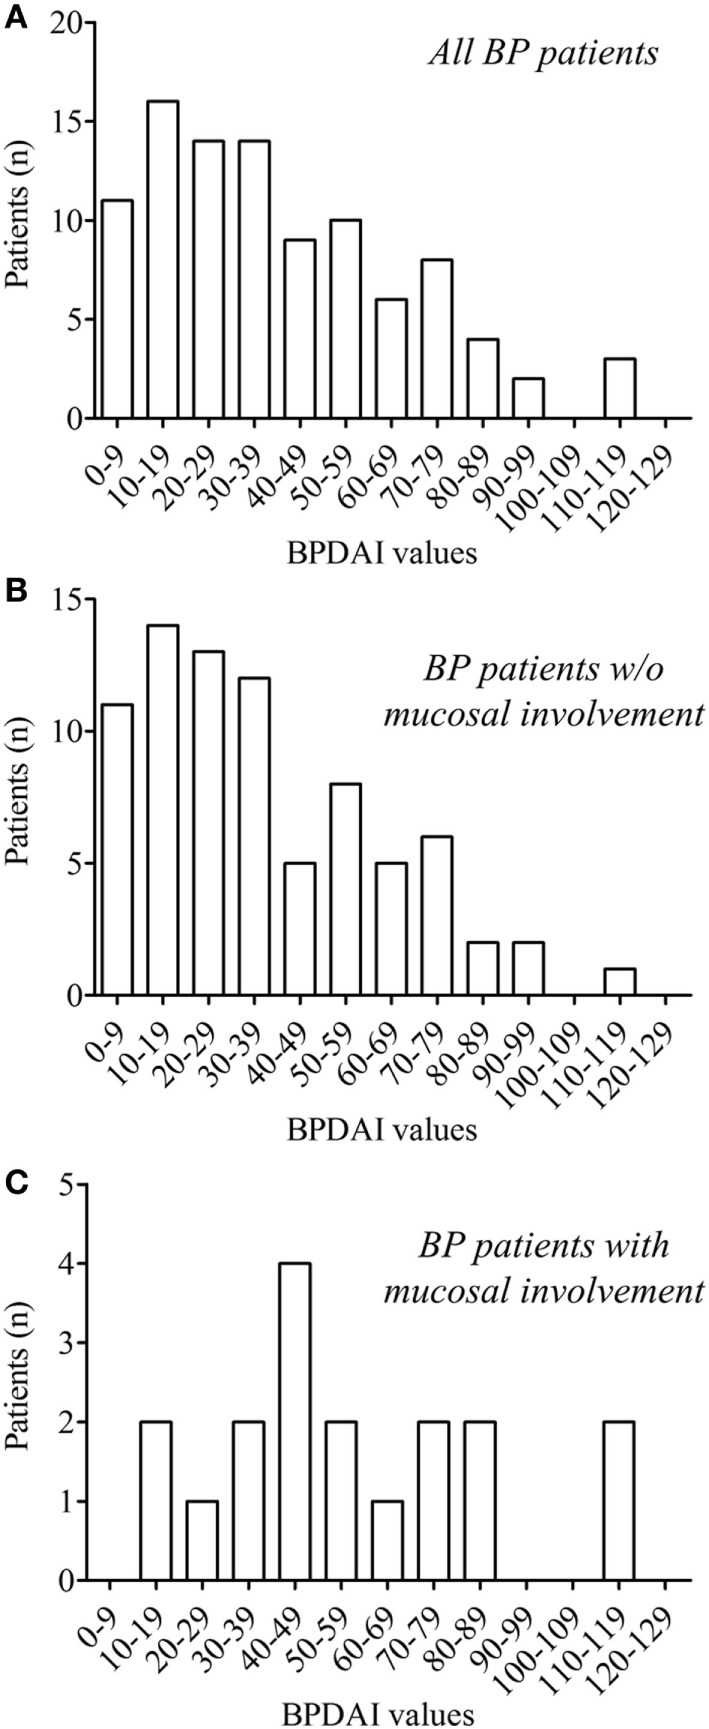
Distribution of the whole bullous pemphigoid (BP) patients (n = 95) (A) and of BP patients without (n = 77) (B) and with (n = 18) (C) mucosal involvement according to total BP Disease Area Index (BPDAI) values at the time of diagnosis. In the whole BP group and in the subgroup of BP without mucosal involvement, the number of BP included decrease when the values of the BPDAI increased, whereas BP patients with mucosal involvement were evenly distributed. Comparison of the cumulative distribution by the Kolmogorov–Smirnov test showed significant difference between BP patients with (C) and without (B) mucosal involvement (D = 0.6154; P = 0.008).